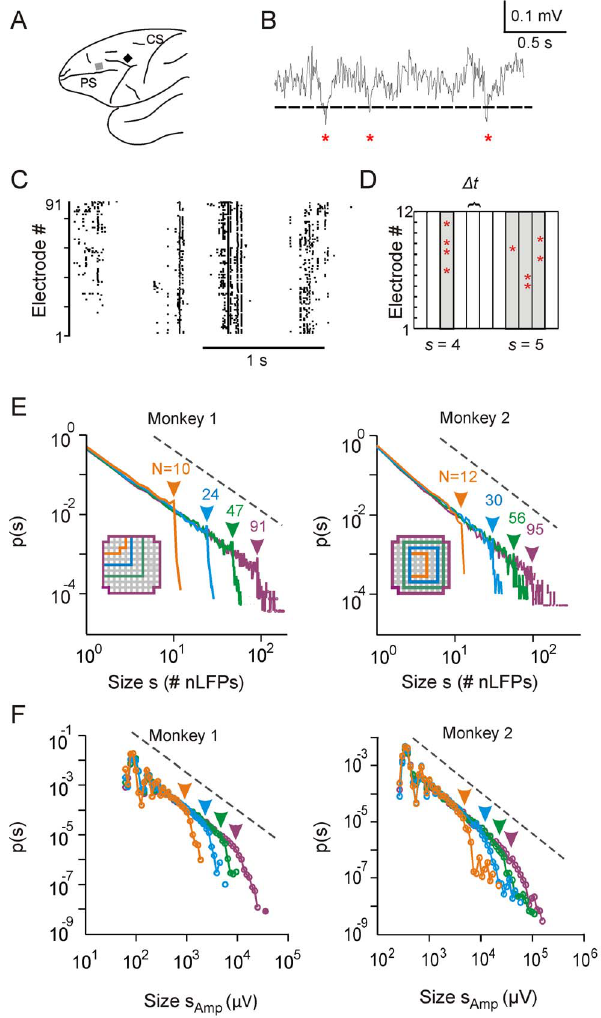
Figure 1. Observation window limit introduces cut-off in avalanche size distributions. ( A ) Sketch of macaque brain with microelectrode array locations (squares; black: premotor cortex, monkey 1; gray: prefrontal cortex, monkey 2). CS : central sulcus; PS : principal sulcus. ( B ) An example trace of an LFP signal, showing the detection of nLFPs (marked by asterisks) using a threshold of 2 2.5 SD (dashed line). ( C ) Raster plot of nLFPs detected from all 91 electrodes (monkey 1) in a period of 2 seconds. nLFPs are represented by individual dots in the plot. ( D ) nLFPs occurring during either the same or consecutive time bins are detected as a spatiotemporal cluster with the size, s , defined as the number of nLFPs involved. ( E ) Avalanche size distributions are plotted in double-logarithmic coordinates for four observation windows, i.e., groups of electrodes in the recording array. The size of the observation window, N , is defined as the number of electrodes within the window (see inset for spatial coverage of the windows). The positions of arrows indicate the values of the corresponding N . ( F ) Continuous avalanche size distributions are plotted for the same observation windows with the size of an avalanche, s Amp , defined as the summated absolute amplitudes of all nLFPs involved. The positions of arrows indicate the values of N 6 mean absolute nLFP amplitude across all electrodes. For visual comparison, a power law with exponent 2 1.5 is shown in E and F (dashed lines). E is re-plotted from [17,32].